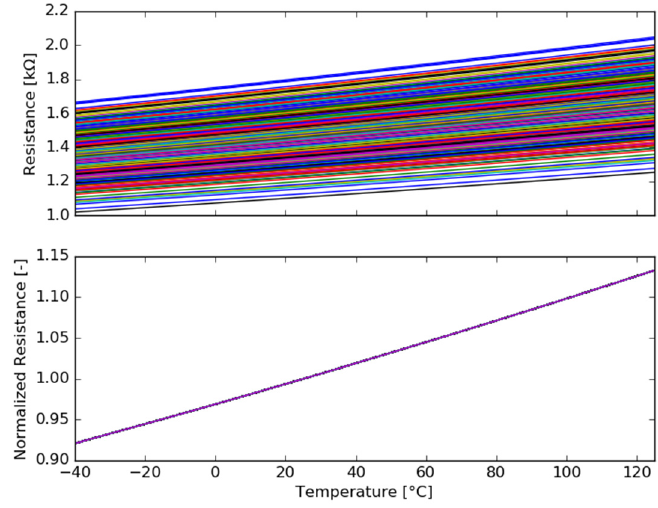
Figure 15. Monte Carlo simulations of the resistance of the on-chip calibration resistor.